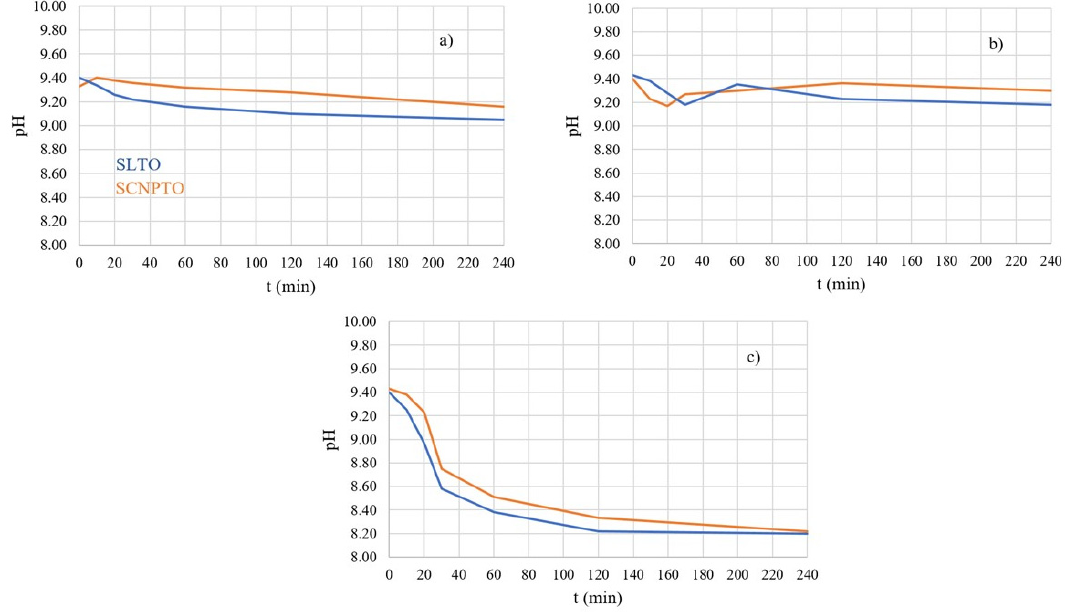
Figure 6. pH change during pindolol photodegradation in the presence of perovskites under ( a ) SSI, ( b ) UV ‐ LED, and ( c ) UV irradiation.